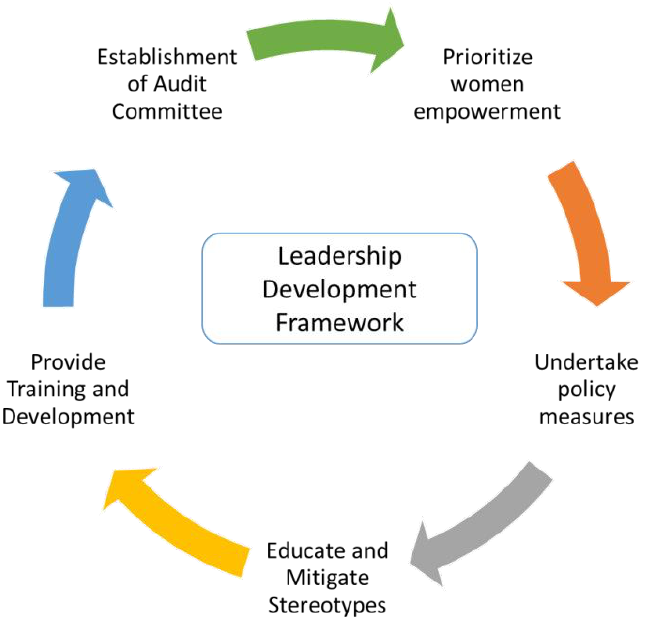
Figure 1: Leadership development framework women; Source: